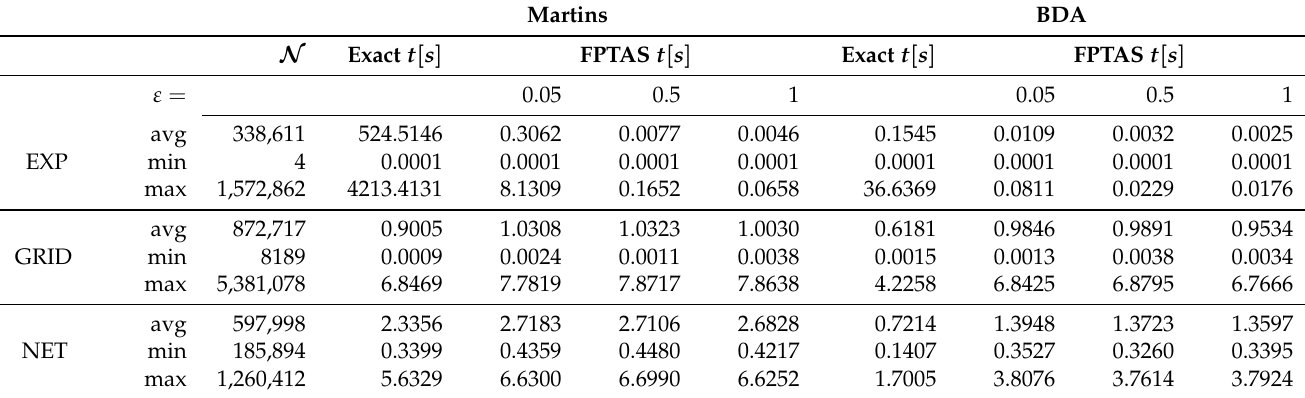
Table 3. Results from one to all runs of biobjective Martins-FPTAS and MD-FPTAS.